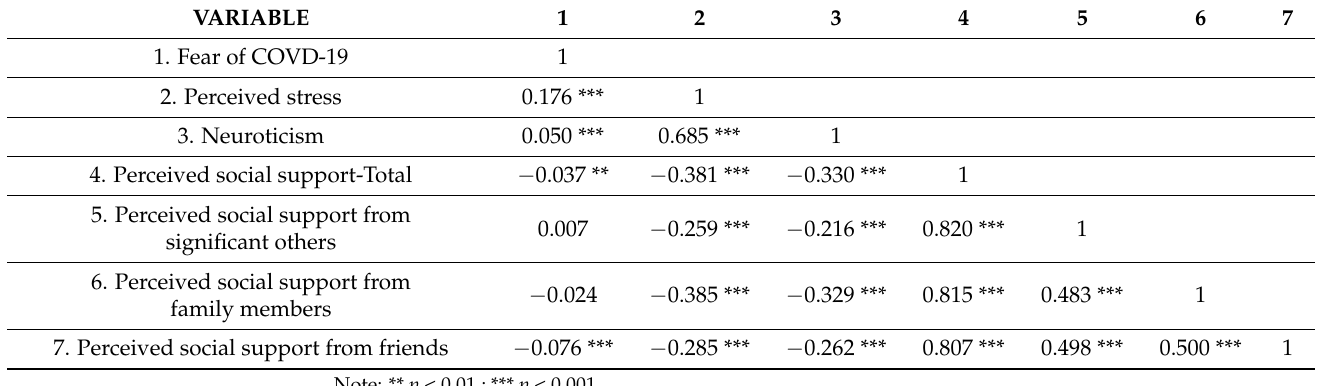
Table 3. Correlation coefficients and descriptive statistics among variables.